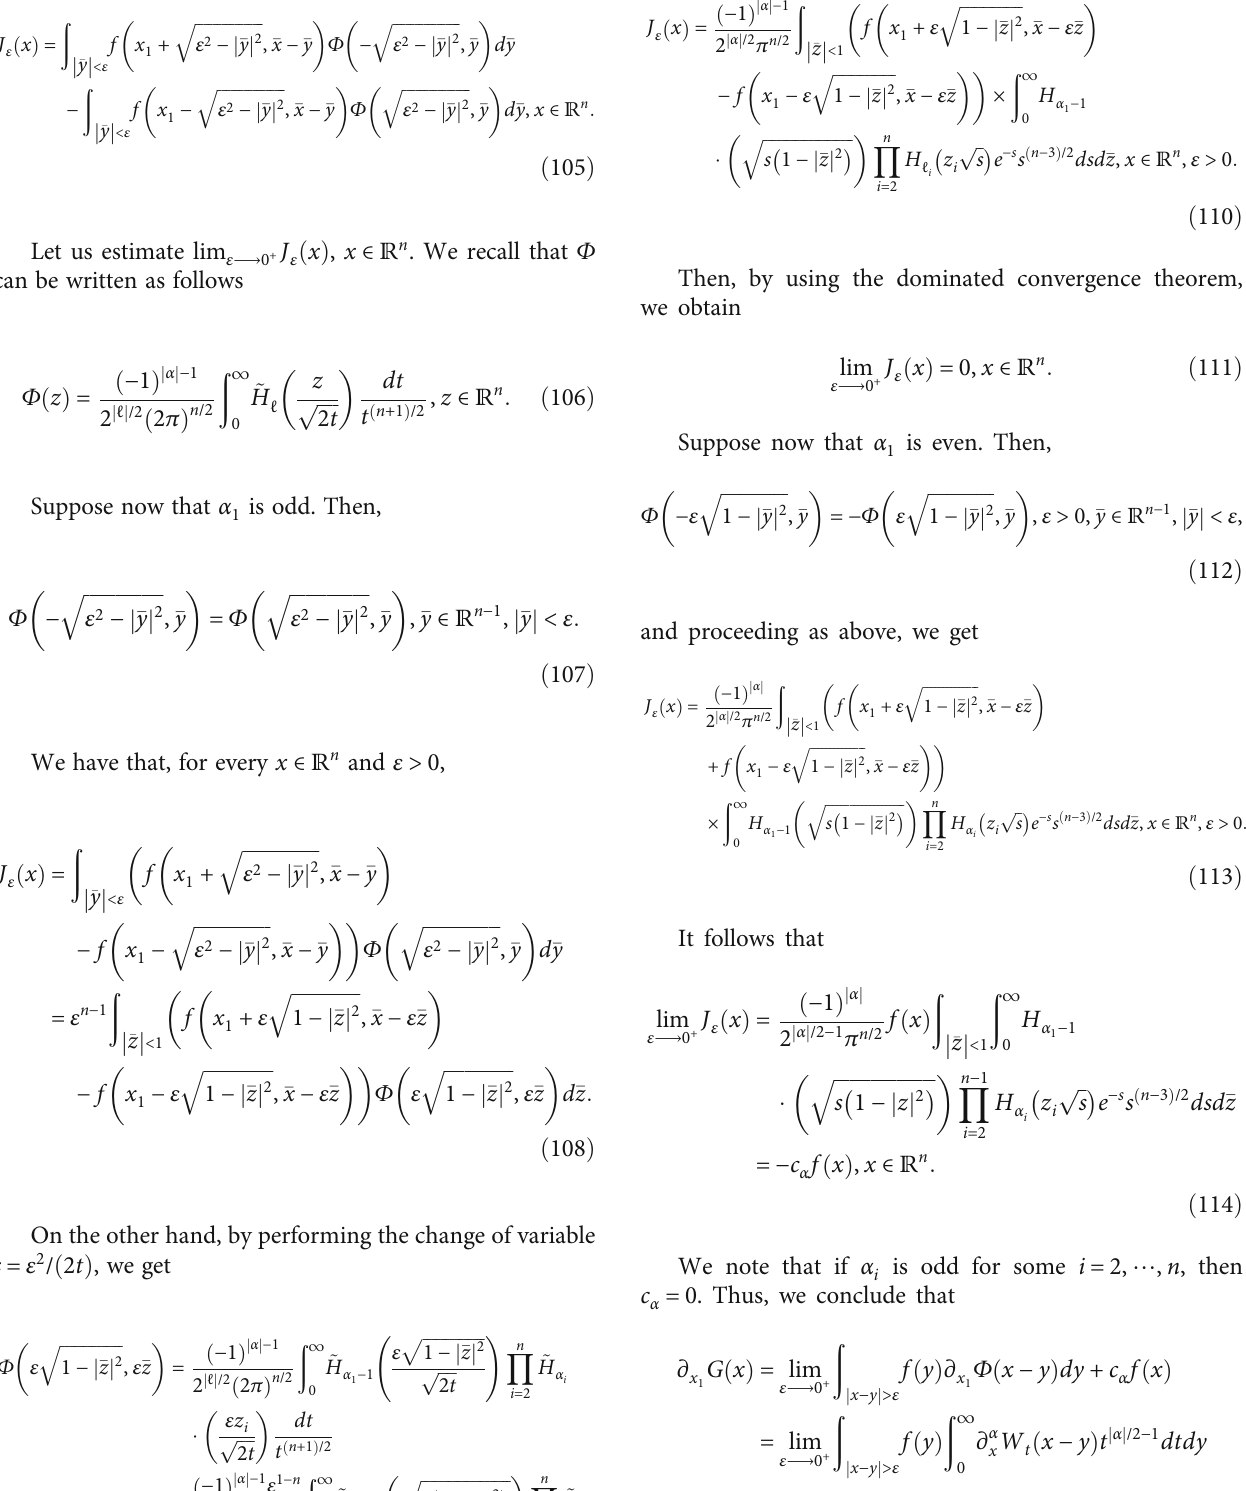
ffiffiffiffiffiffiffiffiffiffiffiffiffiffiffiffiffiffiffiffi